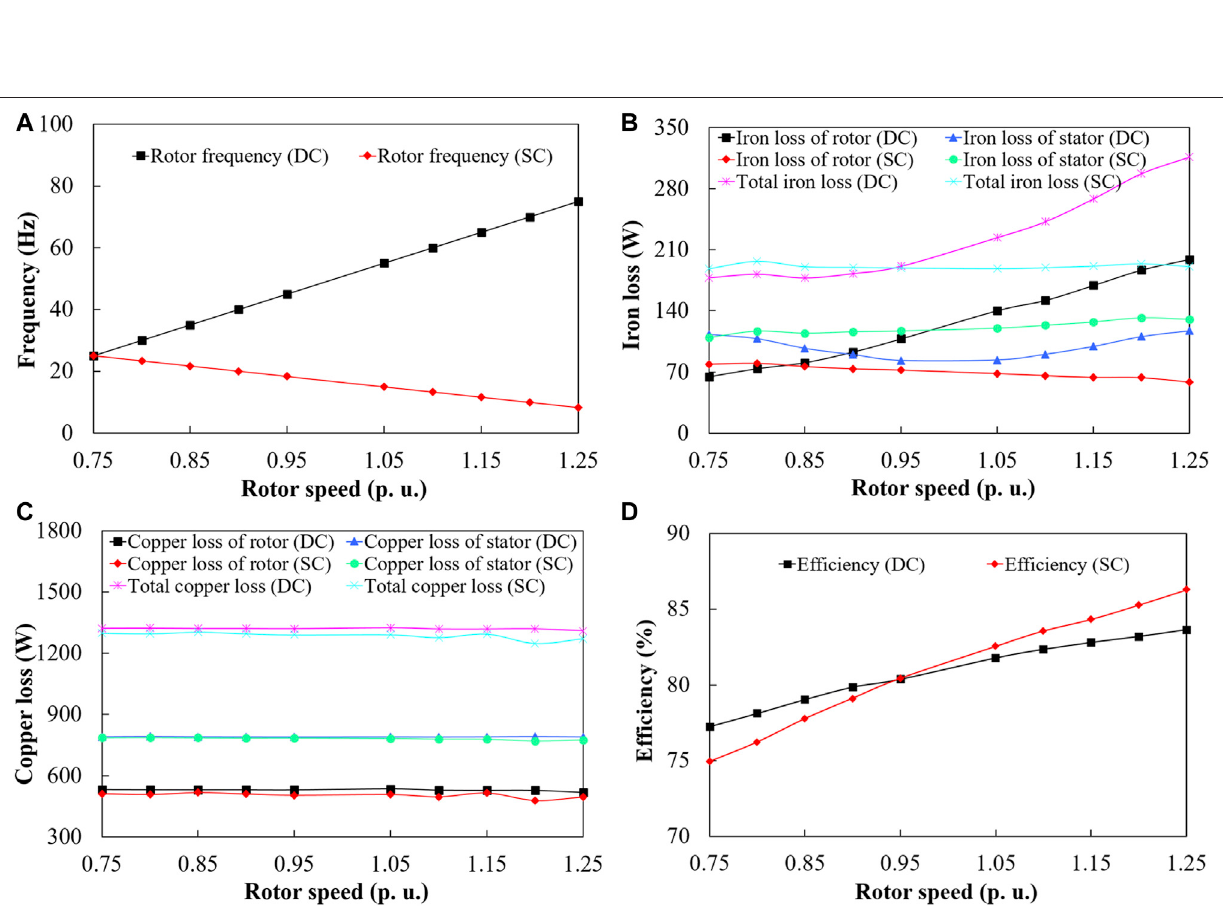
Frontiers in Energy Research |